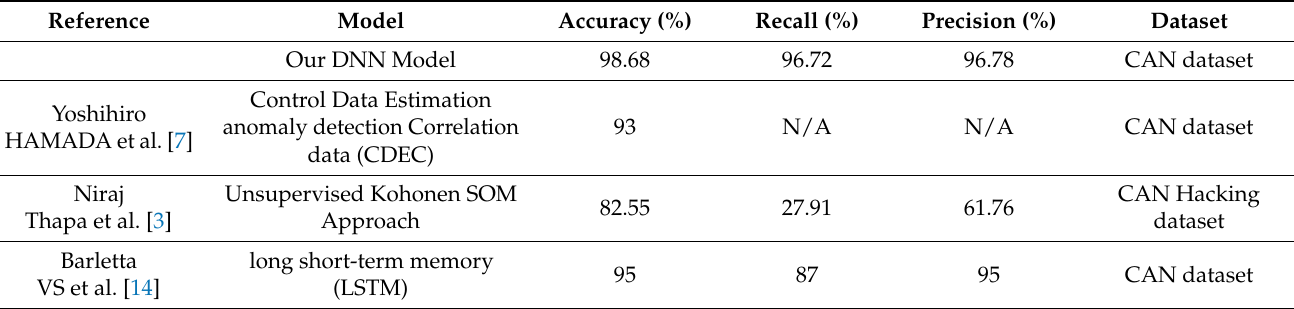
Table 9. Overall comparison of classification models